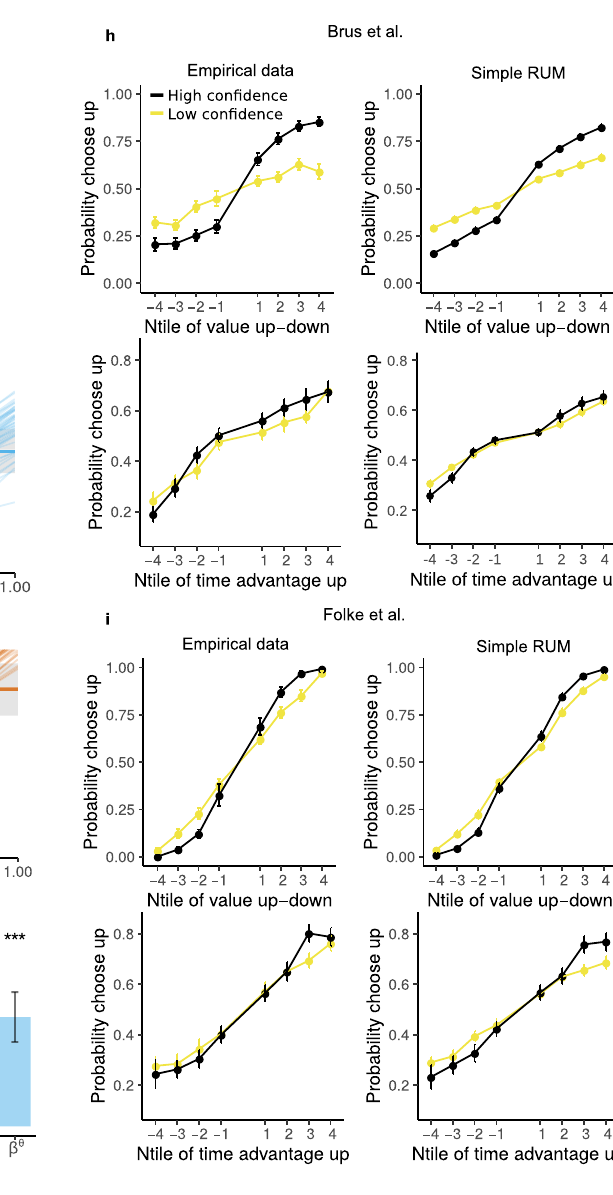
of θ and k as a function of con fi dence explains the data more parsimoniously compared to the standard RUM models (Supple- mentary Fig. 9). Thus, these converging results ensure that they are not a consequence of the speci fi cs of our design or potential cultural differences.